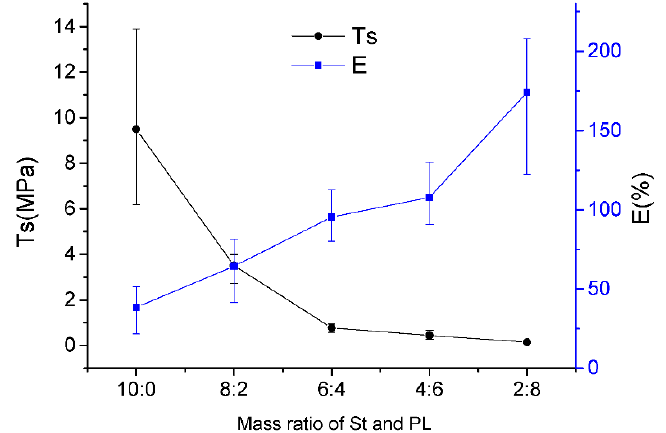
Figure 2. Mechanic curves of the composite films with different St/PL mass ratios.